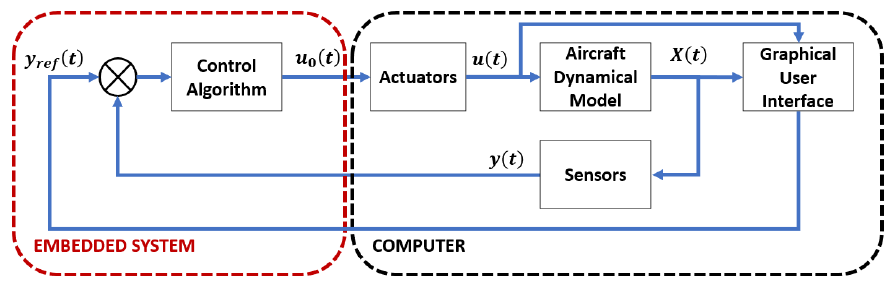
Figure 9. Overall proposed hardware-in-the-loop simulation